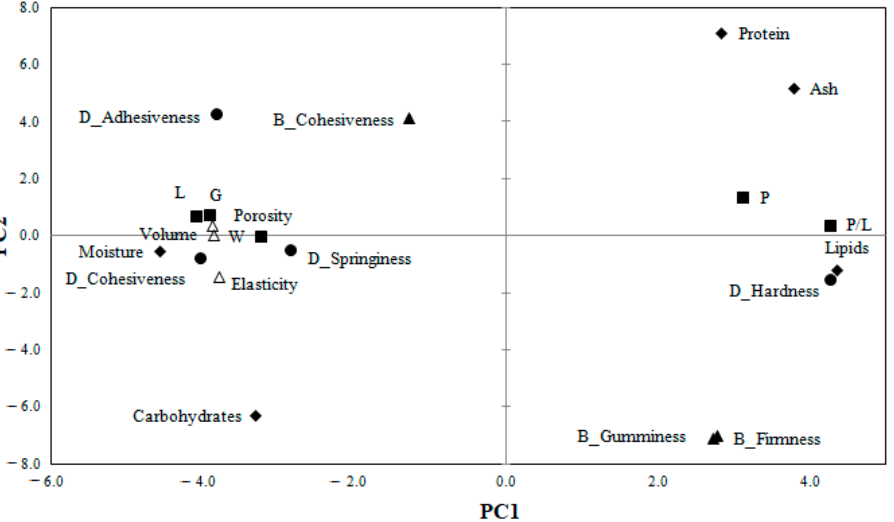
Figure 3. Principal component correlation loadings between wheat-amaranth composite flour chemical composition, dough rheological and textural parameters, and bread technological and textural parameters.